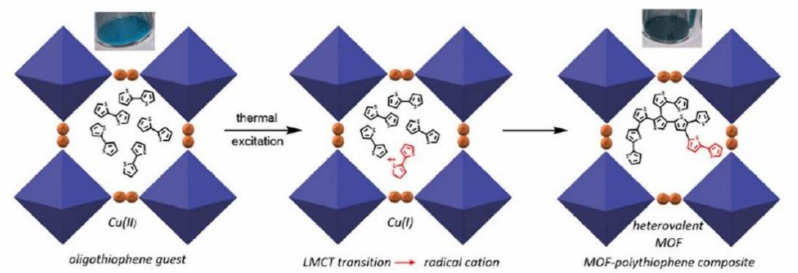
Figure 7. Schematic illustration of the host–guest composites of polythiophenes in HKUST-1 by the direct reaction of adsorbed aryl monomers [74]. Copyright 2019, American Chemical